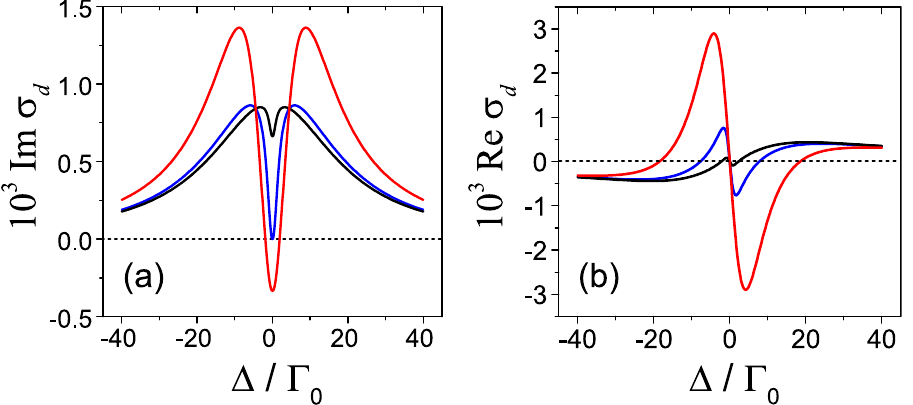
Figure 2. Real part ( a ) and imaginary part ( b ) of σ d . Here σ = I 0 2 (blue line). The black and red line represent the data for Ω γ Ω = Γ 2 c r for the results are: Γ / Γ 0 = 20, γ t / Γ 0 = 1, and Ω = 0.1 Γ 0